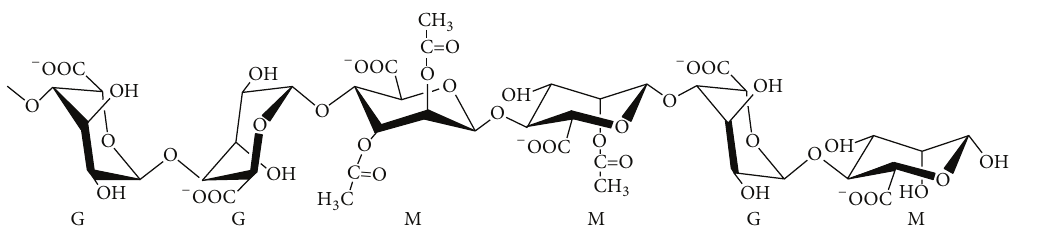
Figure 2: Representation of the chemical structure from acetylated alginates produced by Azotobacter vinelandii bacterium [28]. Mannuronic (M) and guluronic (G) acid residues are represented in the alginate